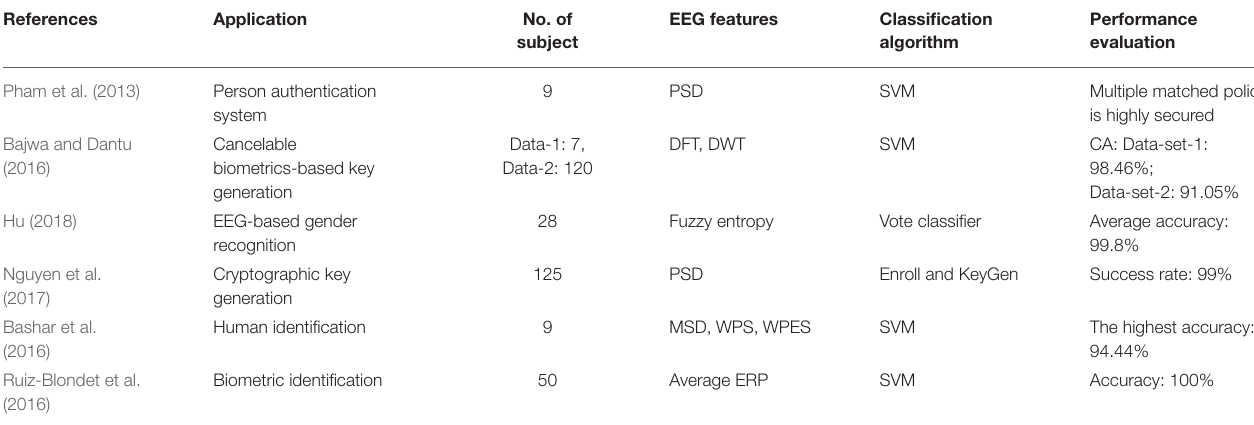
TABLE 6 | Summary of EEG-based BCI biometrics